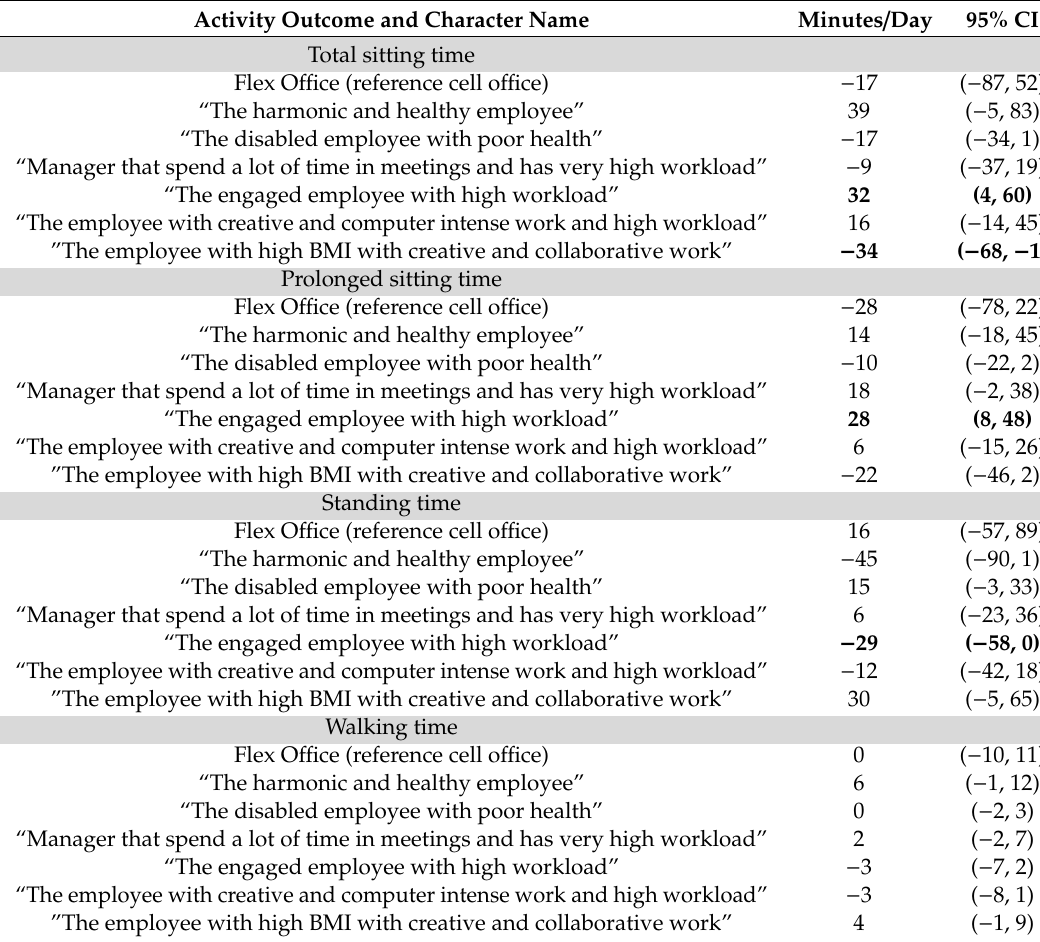
Table 3. Results from robust regression analysis, showing the impact of character types and o ffi ce type on activity outcomes. The e ff ects of character types are reported per interquartile range (IQR) increase. IQR is defined as the di ff erence between the 75th and 25th percentile of the factor scale. Statistically significant outcomes are marked in